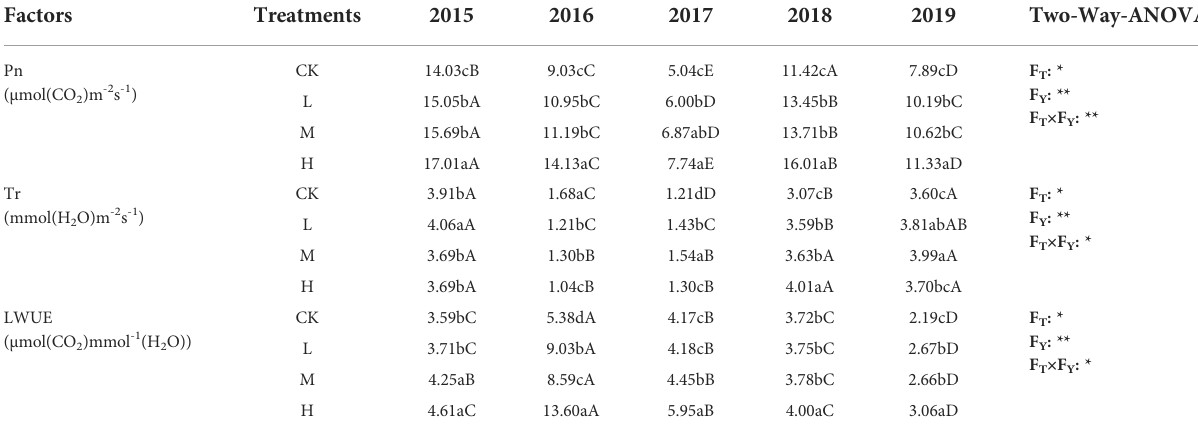
TABLE 4 Photosynthetic physiological characteristics at fi lling stage of winter wheat under different treatments in different years. Factors